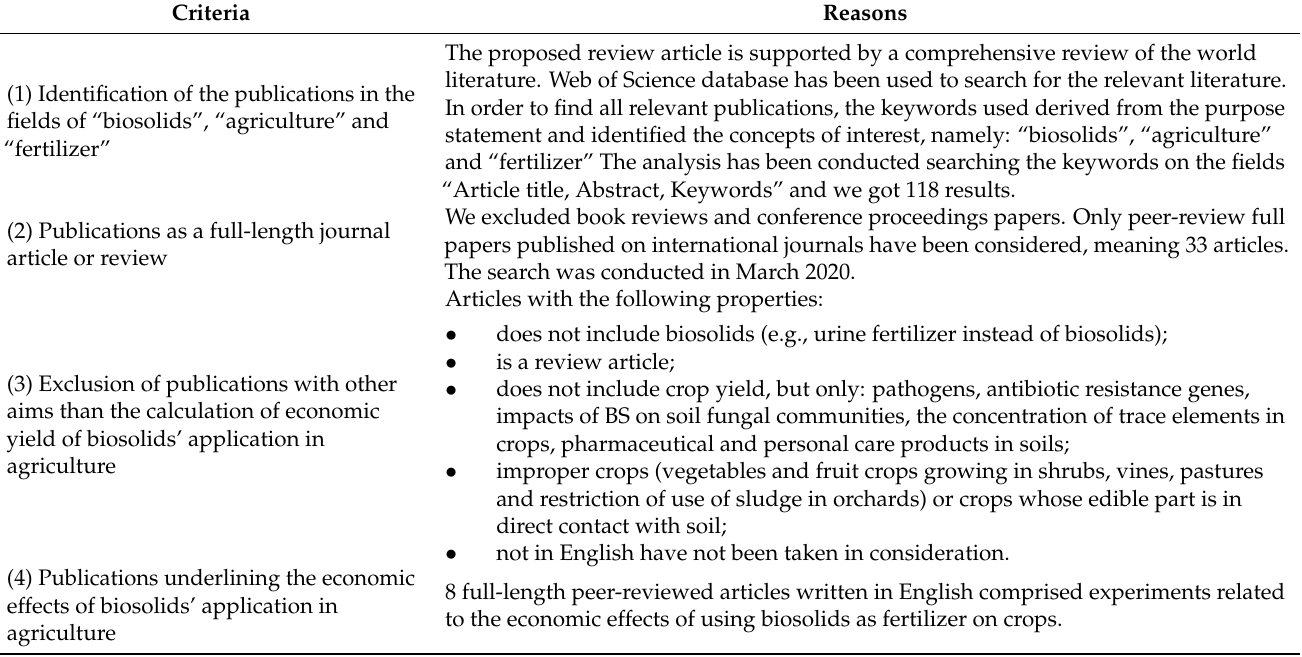
Table 1. Protocol for the literature